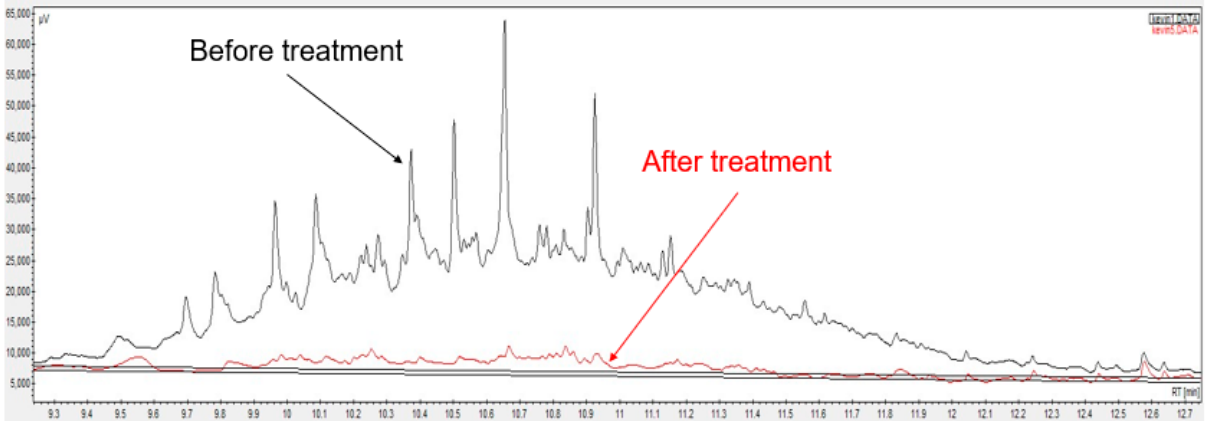
Figure 6. Peaks of oil pollutants before (black) and after (red) treatment by rhamnolipid biosurfactant foam and nZVI.